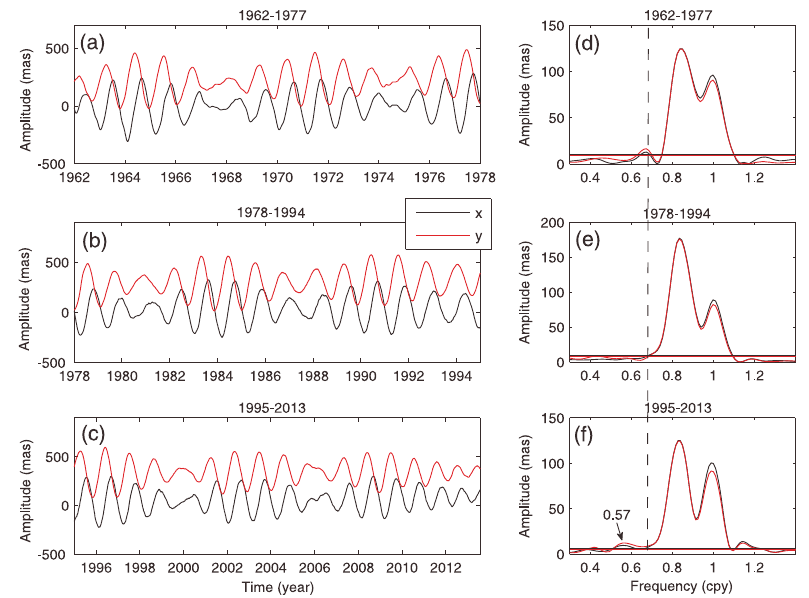
Figure 3. The three sub-series divided from the EOP C04 series (1962–2013) and their corresponding amplitude spectra. The vertical dashed line is located at 0.687cpy, and the horizontal lines denote the RMS noise amplitudes of the frequency bands 0.2–0.75cpy and 1.05–2.0cpy, which are used as the background noise levels of their corresponding spectra. For the x - and y -components of the 1962–1977 series, the RMS noise amplitudes are 9.5 and 9.2mas, respectively; for those of the 1978–1994 series, they are 8.8 and 8.2mas; for those of the 1995–2013 series, they are 5.4 and 5.5mas.